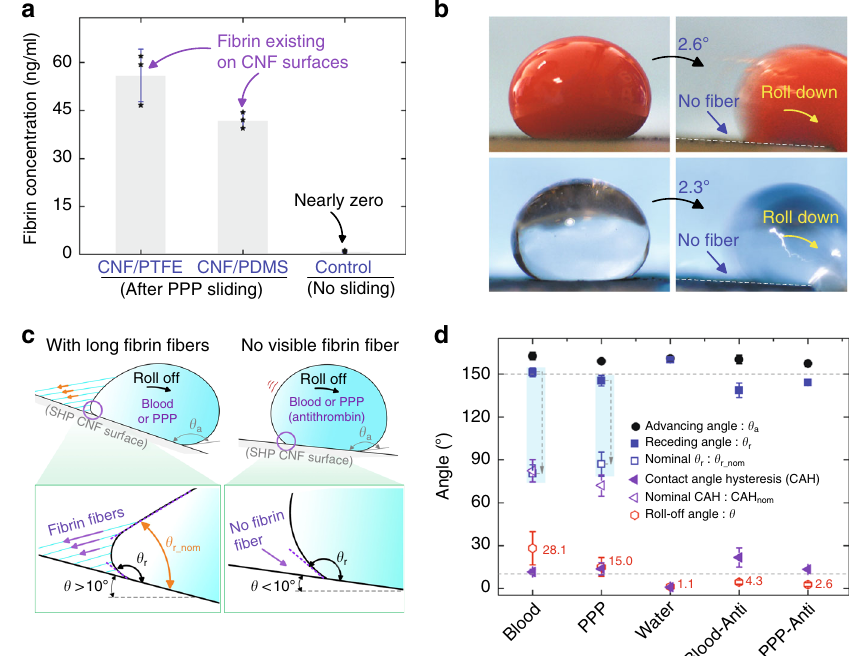
Fig. 2 Fibrin con fi rmation. a Fibrin ELISA test con fi rmed the existence of fi brin on the superhydrophobic CNF surfaces after a sliding test by plasma ( n = 3). b Blood and PPP droplets with anti-thrombin (20 μ l) quickly rolled down the superhydrophobic CNF/PTFE Ti surface at a small tilt angle without generating fi brin fi bers at the receding side. c Actual and nominal receding angles for blood or PPP droplets sliding down the superhydrophobic CNF surface with or without fi brin fi bers; θ a : the advancing angle, θ r : the actual receding angle, and θ r_nom : the nominal receding angle; measurement of θ r_nom is explained in detail in Supplementary Fig. 8. d Dynamic contact angles for water droplets and blood or PPP droplets with and without anti-thrombin on the superhydrophobic CNF/PTFE Ti surface ( n = 4); contact-angle hysteresis CAH = θ a − θ r , and nominal contact-angle hysteresis CAH nom = θ a − θ r_nom ; droplet volume: 20 μ l; Blood-Anti or PPP-Anti, respectively, represents blood or PPP with anti-thrombin. Data in a and d are shown as mean ± SD, the error bar represents SD, and individual data points in a are represented by black stars. Source data for a and d are provided as a Source Data fi